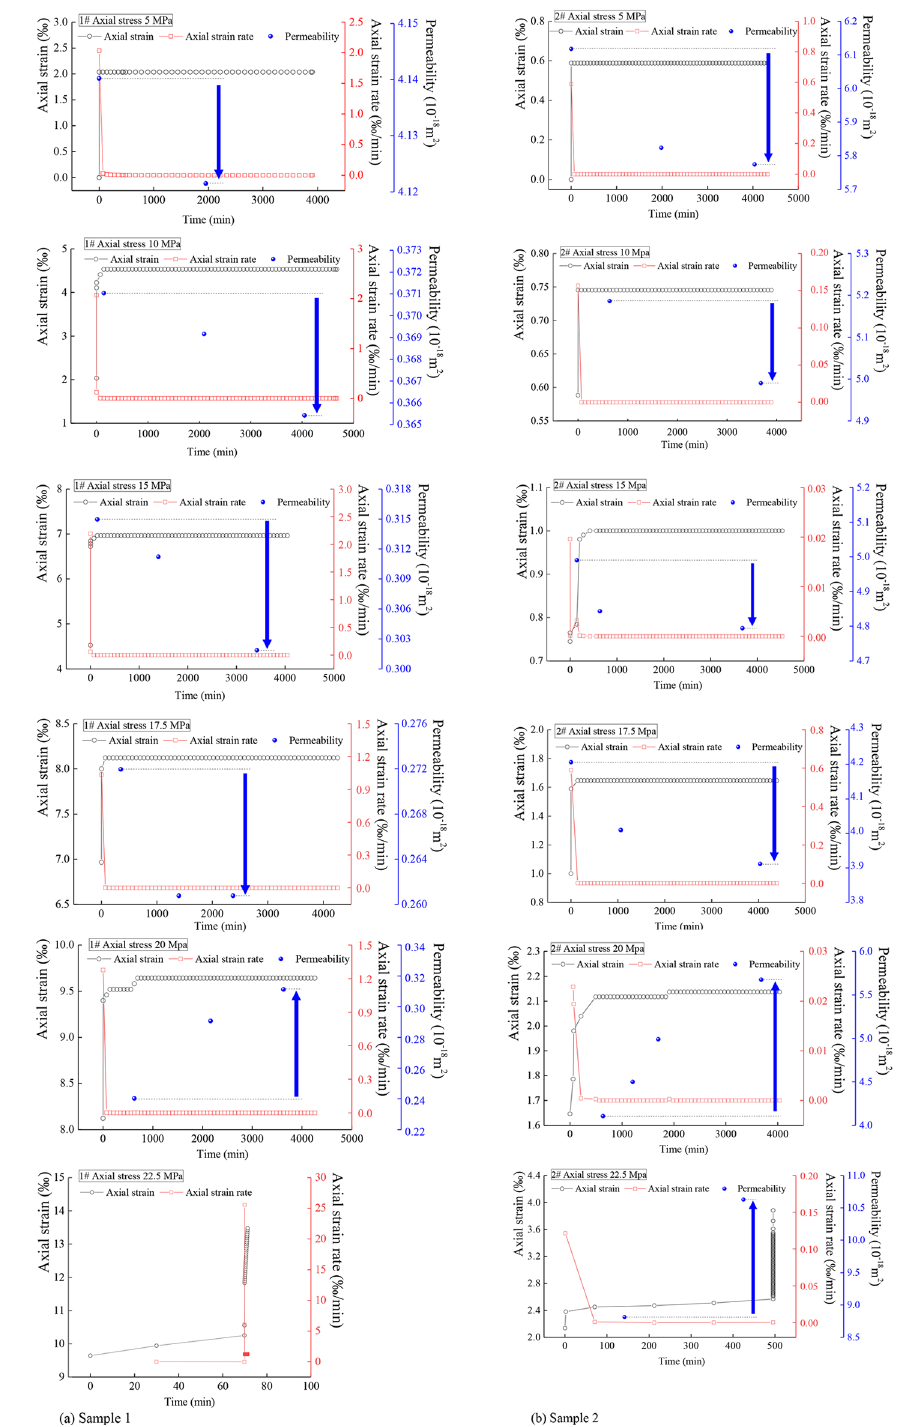
Fig. 4 The strain rate and perme- ability changing with time under different axial